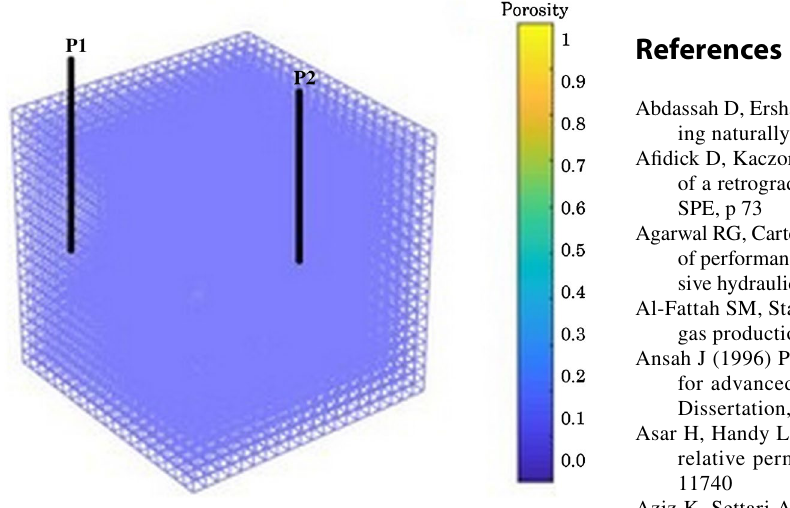
Fig. 18 Cartesian gridding system of case #2